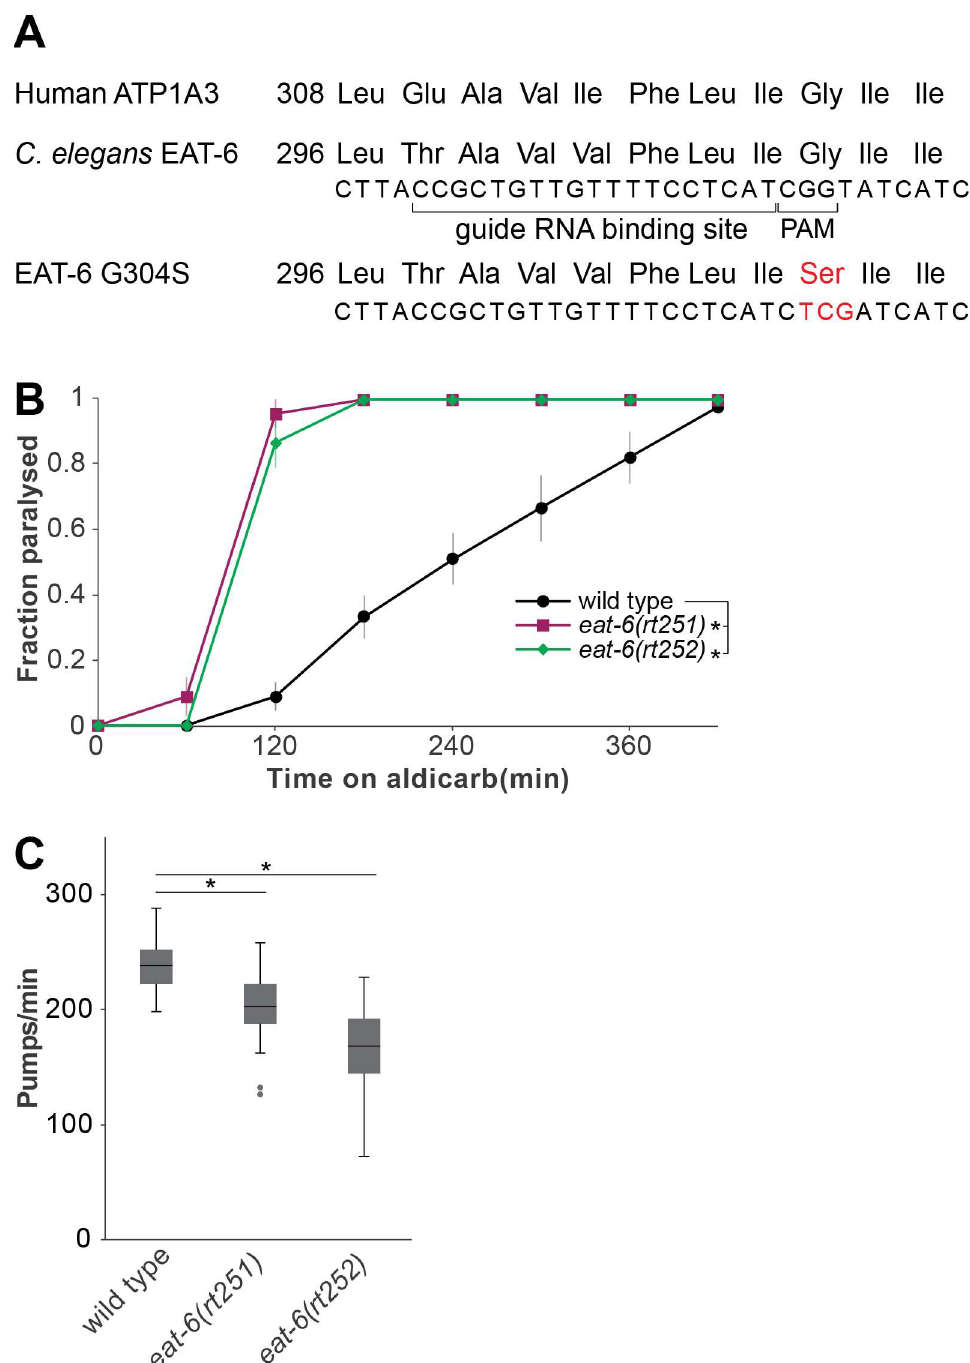
Fig 1. EAT-6 G304S mutation is analogous to ATP1A3 G316S and perturbs neuromuscular junction function. (A) EAT-6 is homologous to ATP1A3 and glycine 304 (G304) is in a well-conserved region. The PAM site and the sgRNA bindingsite used for EAT-6 G304S (red) are marked with brackets. (B) For the two allelesof eat-6 isolated independently ( eat-6(rt251) and eat-6(rt252) ), G304S caused hypersensitivity to aldicarb(3 trials ± SEM, * : log-rankp-value < 0.05). (c) eat-6 G304S animalsexhibiteddecreased pumpingrates (median, flankingquartilesin Tukey format; 3 trials; * : Mann-Whitney U-test (two-tailed) p-value < 0.05; n.s.: not significant,p-value >